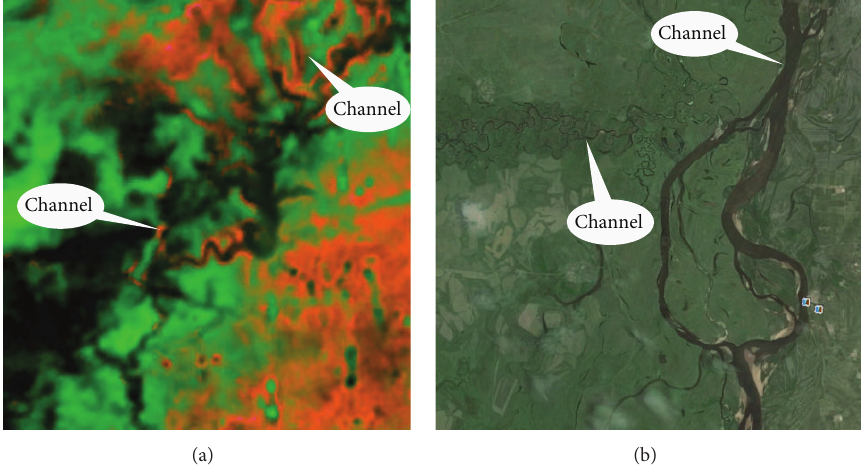
Figure 6: (a) Slice of the color-blended volume; (b) modern rivers on land (image snapped from Google Earth).